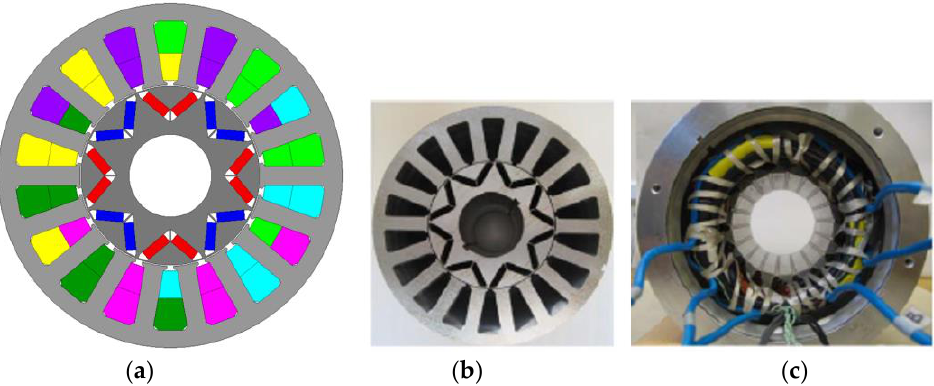
Figure 6. The 6-phase 18-slot/8-pole machine: ( a ) schematic with winding layout and top view of the motor, ( b ) without copper coil and PM, and ( c ) with copper coil and others [4]. © IEEE. Reprinted with permission from Patel, V.; Wang, J.; Wang. W.; Chen, X. The 6-phase fractional-slot-per-pole-